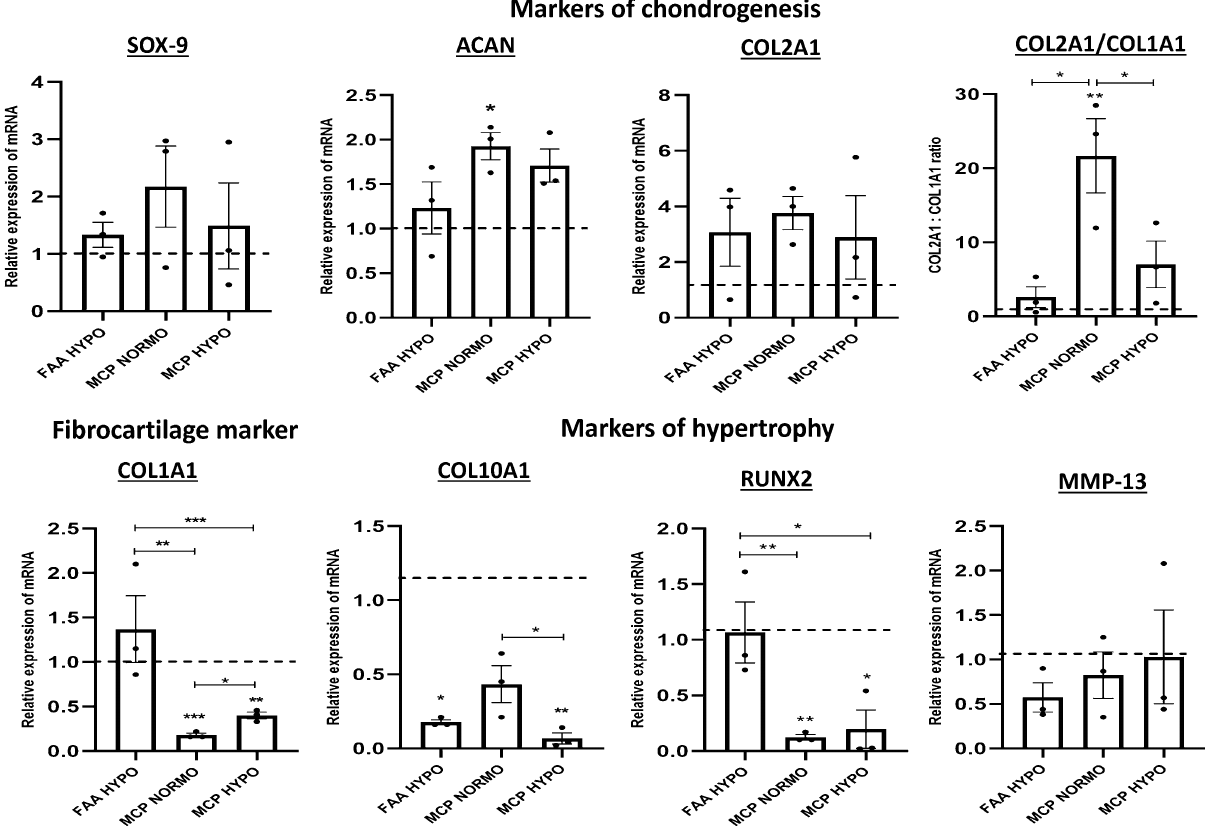
Figure 4. Relative mRNA expression encoding chondrogenic markers (SOX-9, ACAN, COL2A1), fibrocartilage marker (COL1A1), and hypertrophic markers (COL10A1, RUNX2, and MMP-13) were determined by qRT-PCR. All results were normalized to the housekeeping gene, GAPDH(ΔCt), and ΔΔCt was obtained in comparison to the FAA-CP Normoxia group. 2^− ΔΔCt values are expressed as mean ± standard error mean (* P < 0.05, ** P < 0.01). The FAA-CP normoxia levels are represented as dotted lines. The experiments were conducted with three biological samples (n = 3) in two technical replicates. Overall, MCP-N